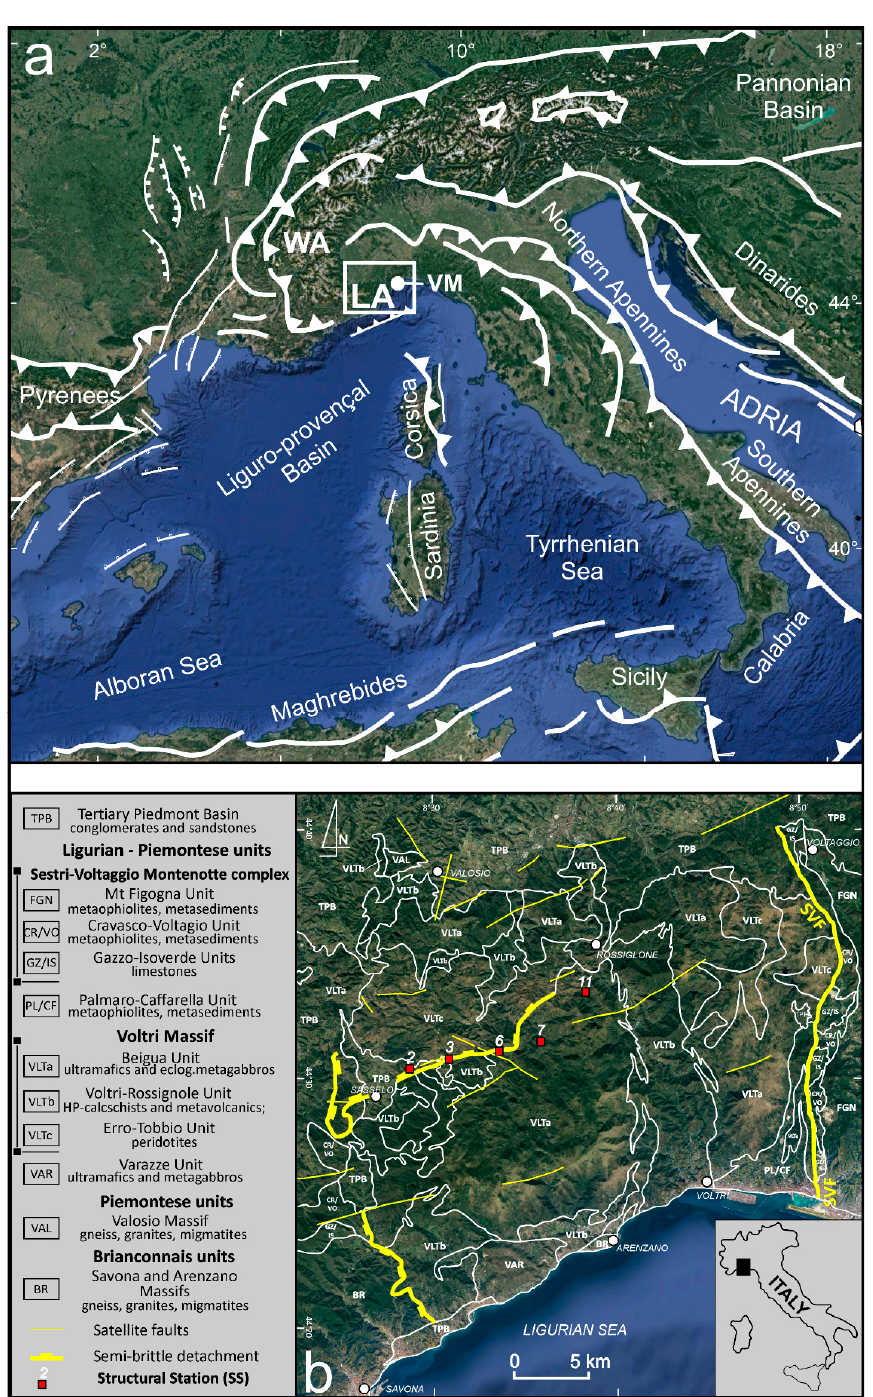
Figure 1. Geographical and geological information concerning the study area: ( a ) Satellite image of the Western-Central Mediterranean (modified from [57] and references therein). Explanation: LA: Ligurian Alps, VM: Voltri Massif, WA: Western Alps. ( b ) Simplified geological map of the Voltri Massif and location of the structural stations (modified after [32,53,55,60] ). Explanation: the numbered red squares are the structural stations (SS) with fault-slip data, as presented by [32] , SVF: Sestri-Voltaggio Fault.